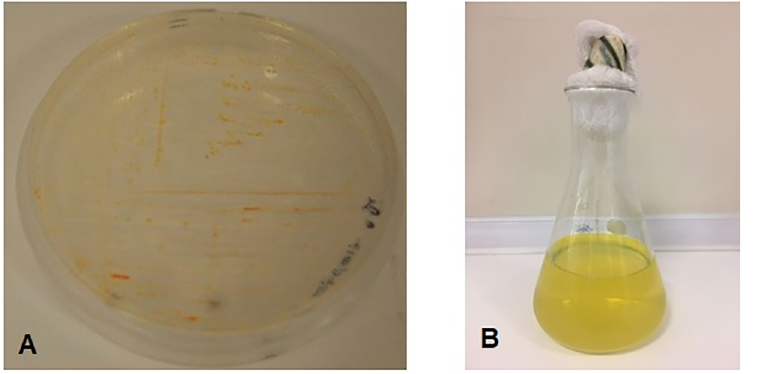
Fig 1. Image of Flavobacterium sp . grown on agar plate (a), and liquid culture